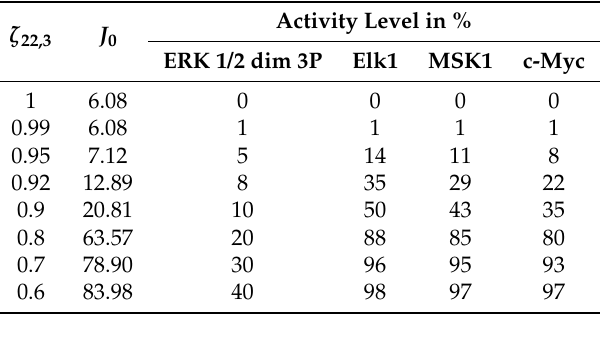
Activity levels of Elk1, MSK1 and c-Myc for increasing inhibition of the third ERK1/2 phosphorylation.